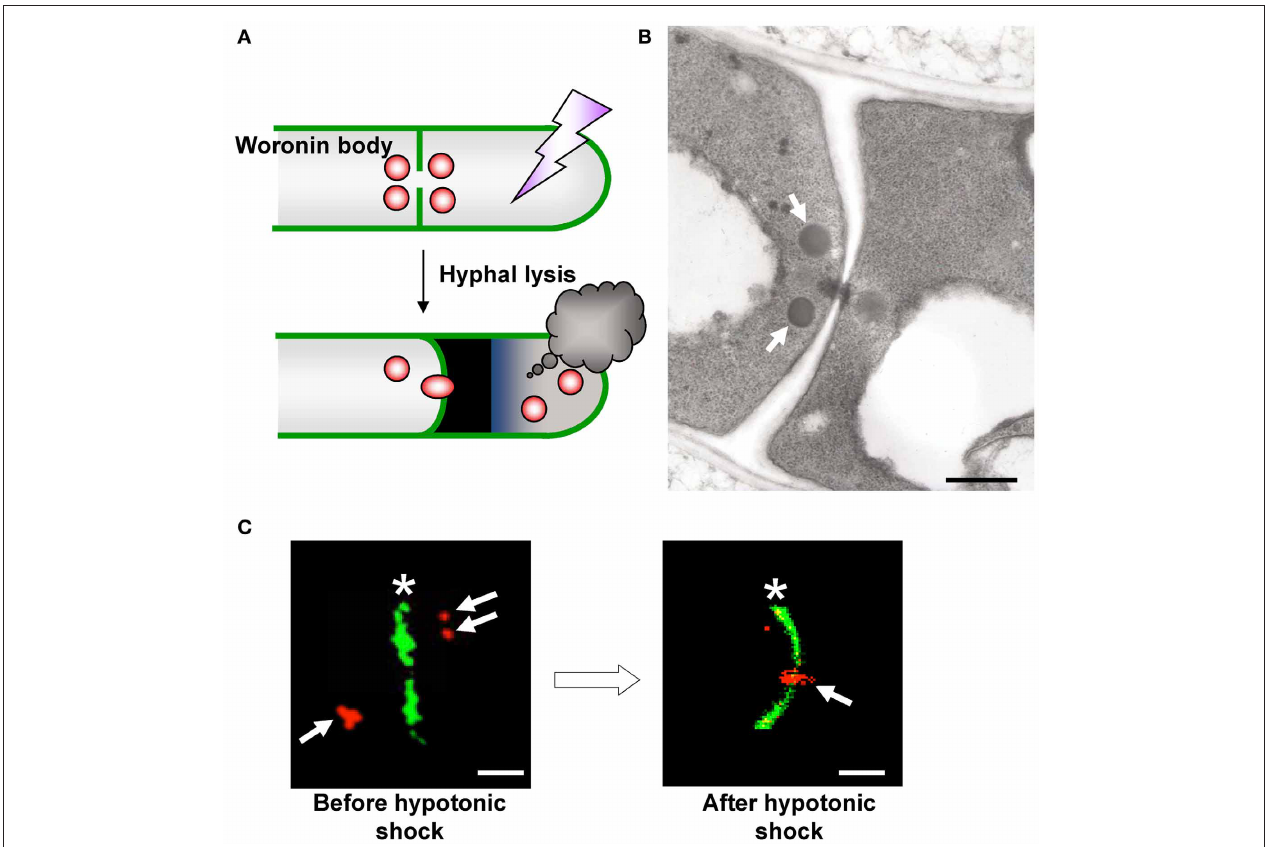
FIGURE 2 | Morphology and function of the Woronin body. (A) Schematic model of Woronin body function. (B) Transmission electron microscopic observation of Woronin bodies (arrows) in A. oryzae (Maruyama et al., 2005). Bar: 500nm. (C) Confocal images of Woronin bodies (red, arrows) and septa